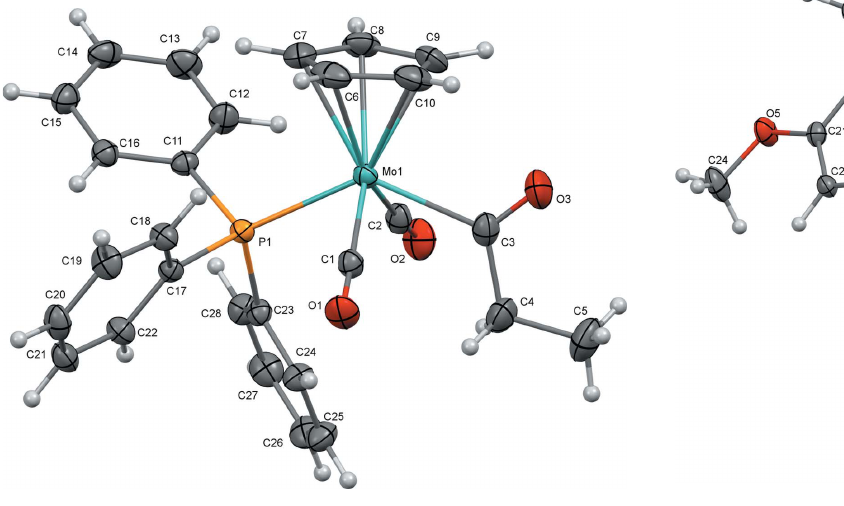
Figure 1 Molecular structure of ( 1 ) with ellipsoids at 50% probability. 2 of 7 Whited et al. (cid:3) cyclopentadienylmolybdenum(II) propionyl complexes Acta Cryst. (2021). E 77